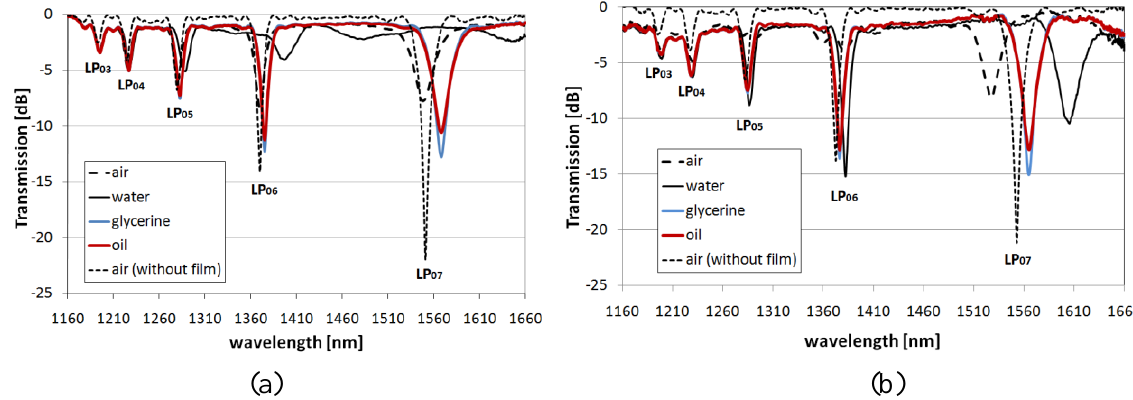
Figure 2. Effect of spectra recovery at high external RI for LPGs written in PS 1250/1500 fiber (Λ = 375 μm) coated with SiN film, where: (a) film thickness is 28.5 nm and x n = 2.293 and (b) film thickness is 74 nm and n = 2.366. The spectrum measured for each grating before deposition of the film is given as a